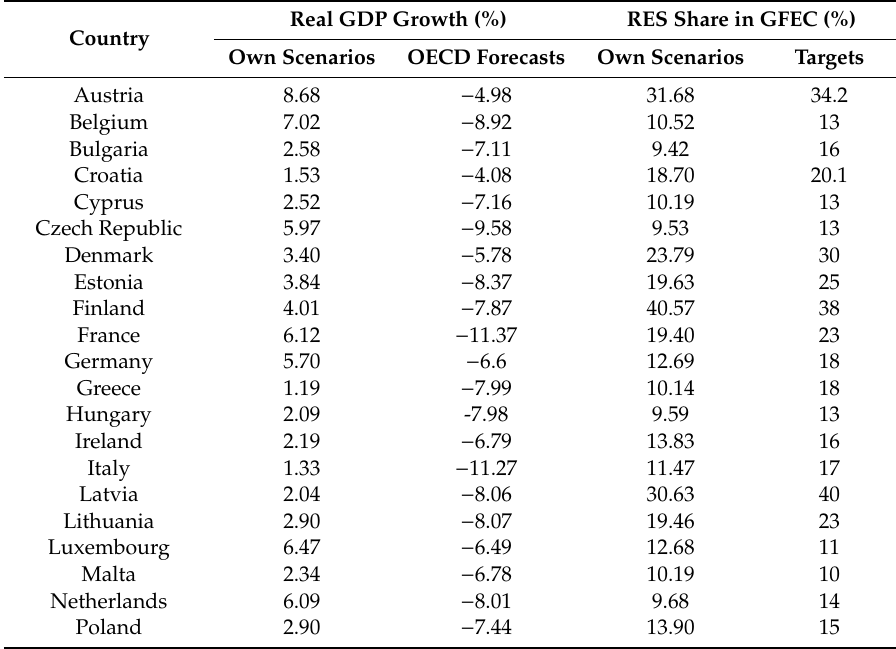
Table 10. Forecasts for real GDP growth and RES share in gross final energy consumption (GFEC) (%) in the EU countries and UK for